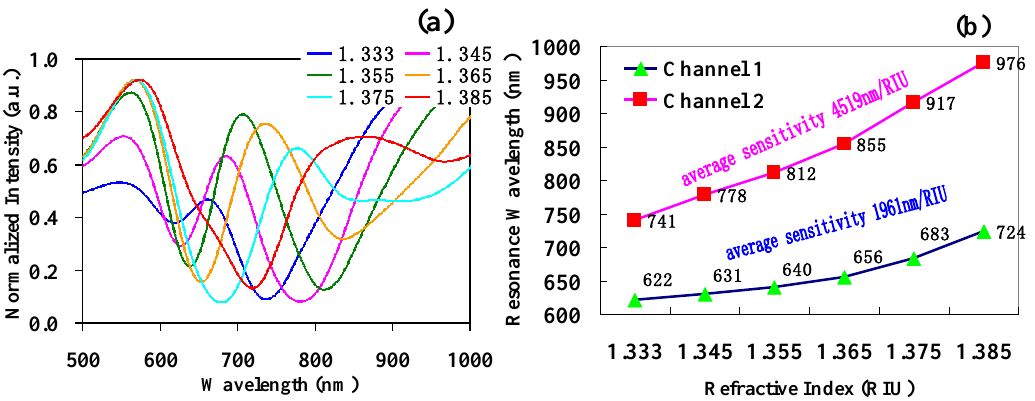
Figure 7. The test results of a dual-channel SPR sensor. ( a ) The test spectrum of the refractive index; ( b ) comparison of the dual-channel resonance wavelength and average sensitivity.